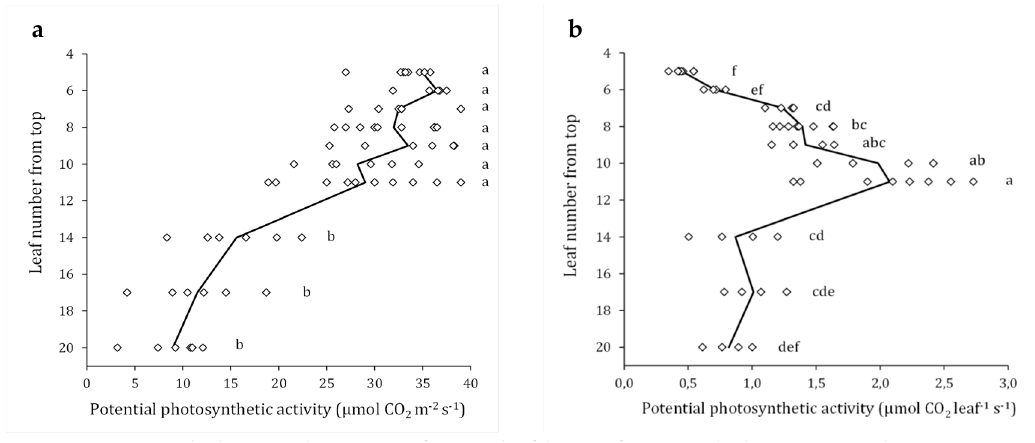
Figure 1. Potential photosynthetic rate of every leaf layer of a control plant expressed per square meter of leaves (µmol CO 2 m − 2 s − 1 ; Figure 1a) and per leaf according to its leaf area (µmol CO 2 leaf − 1 s − 1 ; Figure 1b). Data on an average of 10 independent plants (dark line). The dots show the individual values for each plant. Separate statistical analyses were conducted for Figures 1a and 1b. Letters indicate results of statistical analysis according to Tukey’s test: different letters indicate statistical differences.